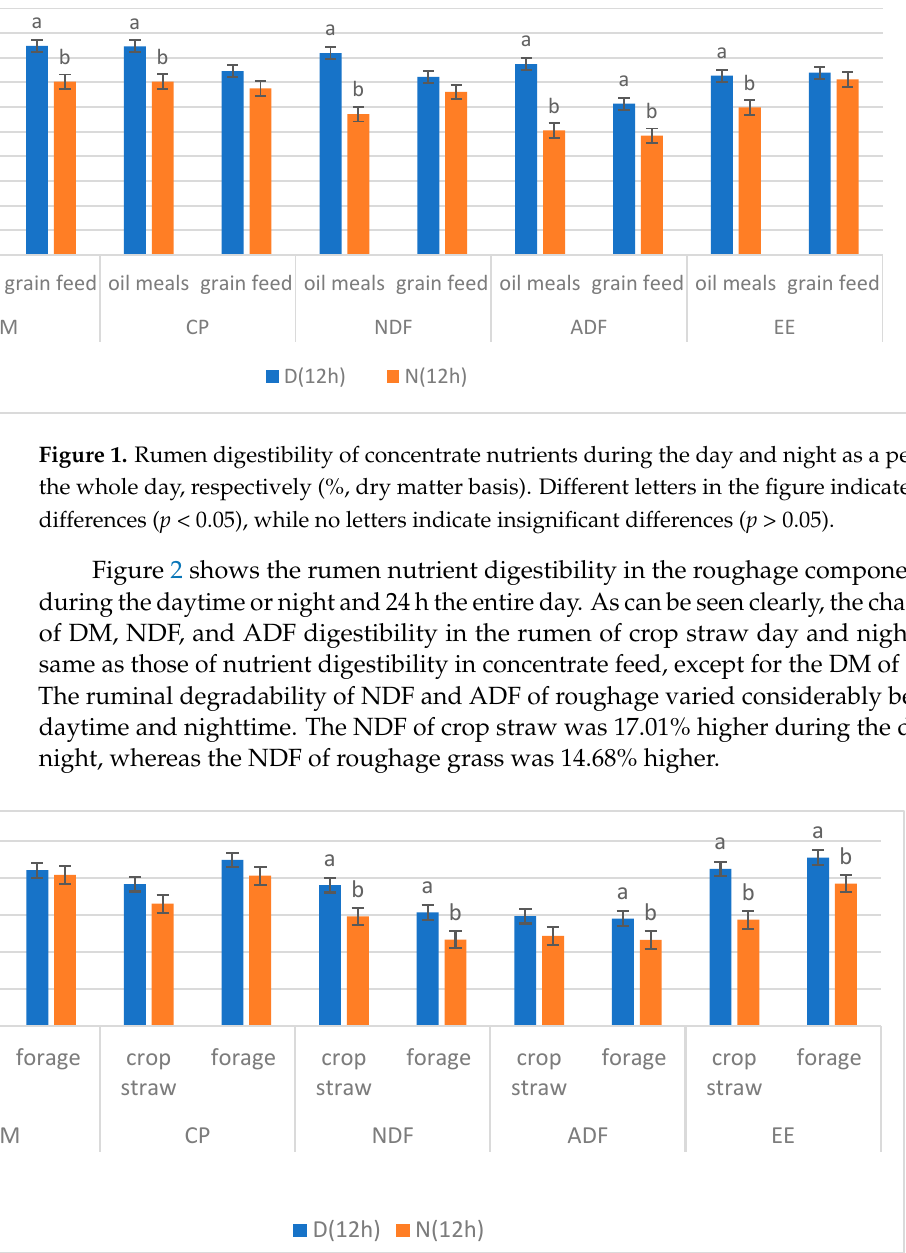
Figure 2. Rumen digestibility of roughage nutrients during the day and night as a percentage of the whole day, respectively (%, dry matter basis). We purchased the roughage from the Beijing Sanshi Dairy Farm., Beijing, China. Different letters in the figure indicate significant differences ( p < 0.05), while no letters indicate insignificant differences ( p > 0.05).